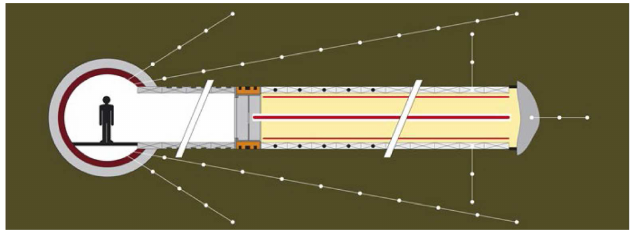
Fig. 13. Schematic representation of the PRACLAY experi- ment located in the HADES URL